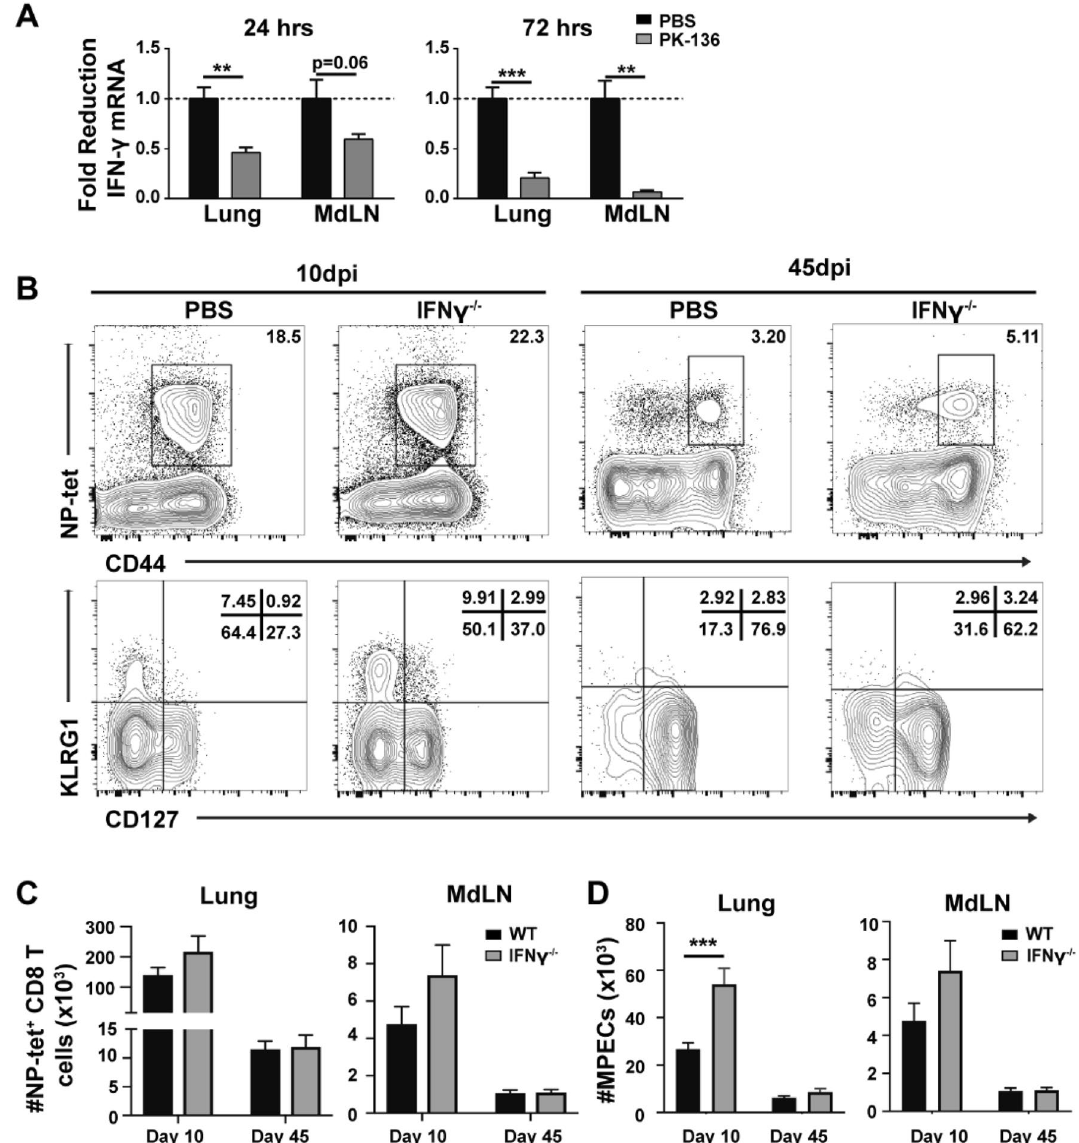
Figure 6. IFN-γ deficiency enhances the total number of memory precursors, but not T mem following viral respiratory infection. C57BL/6 mice were infected with 10 3 PFU x31 and administered the NK depleting antibody on −1, 1, and 3 dpi. ( A ) The relative expression of IFN-γ transcript recovered from bulk lung tissue and MdLN of NK-sufficient (black) and depleted (grey) mice 24 and 72 h post infection. ( B ) C57/BL6 WT and IFN- γ −/− mice were infected with 10 3 pfu x31, sacrificed 10 and 45dpi and frequency of CD8 + CD44 + NP-tet + cells as well as subsequent CD127 and KLRG1 expression assessed. ( C ) Total number ± SEM of activated CD44 + NP-tet + CD8 + cells in WT (black bar) and IFN-γ −/− (grey bar) mice. ( D ) Total number of CD127 + KLRG1 - MPECs in the lung and MdLN of WT (black) and IFN-γ −/− (grey) mice 10 and 45dpi is depicted. Graphs are representative of data from 2 independent experiments using n ≥ 3 mice/group/time point (total 6 animals per group/time point). *p < 0.05, **p < 0.01, ***p < 0.001; unpaired Student’s t-test with Welch’s correction (for mRNA the lung following influenza infection occurs independent of both global and NK cell-derived IFN-γ. Together, these data suggest that NK cells regulate T RM development in the respiratory tract, albeit independent of IFN-γ production. While the mechanism by which NK cells regulate T RM formation within the lung is still unknown, reducing NK cell activation during CD8 T cell priming may provide a mechanism to enhance regional CD8 + T cell protection with a reduced potential for immunopathology.